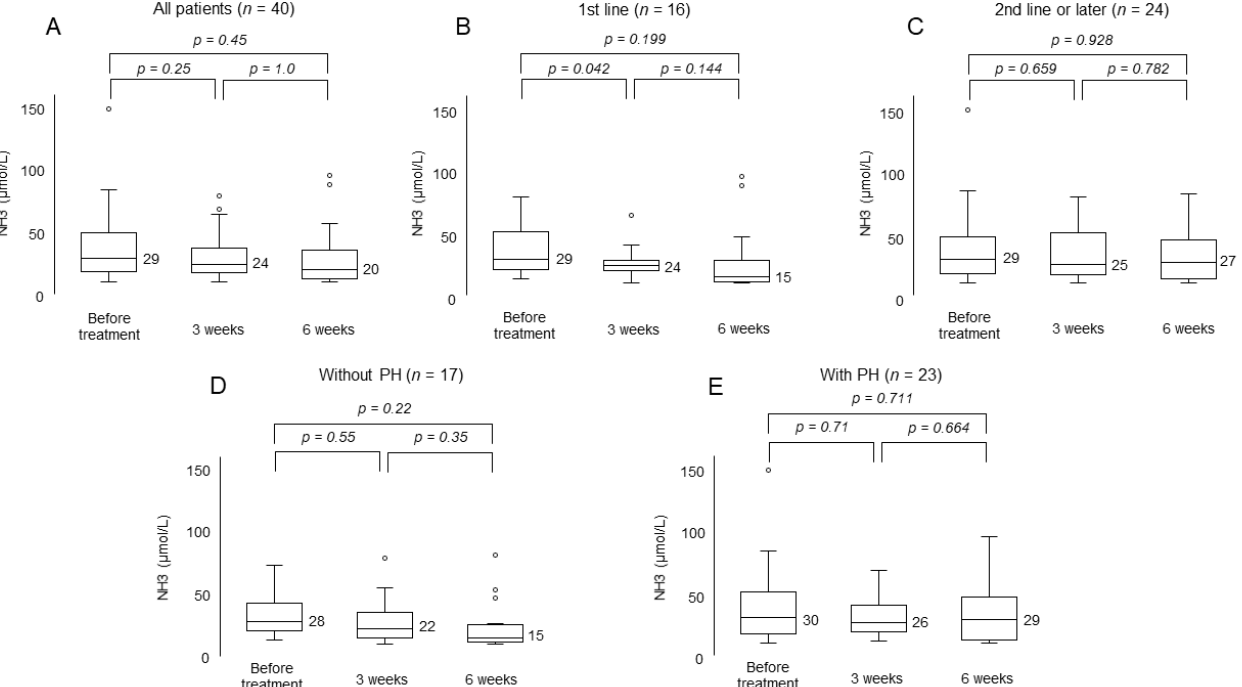
Figure 4. Change in serum ammonia level. ( A ) All patients. ( B ) Patients treated as first-line treatment. ( C ) Patients treated as second-line or later treatment. ( D ) Patients without portal hypertension. ( E ) Patients with portal hypertension. Circles (“ ◦ ”) mean outliers.